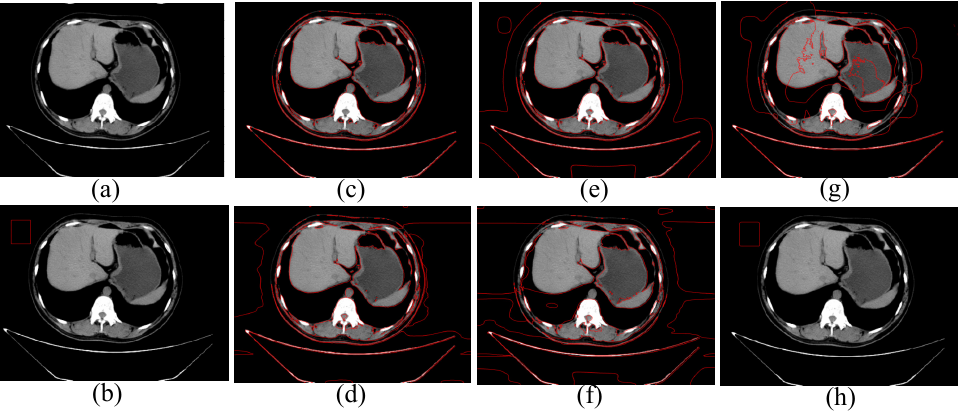
Figure 8. Performance of our method, the LIC model, the LBF model, 0.5-order, 1.5-order on skeleton CT image, and the CV model. ( a ) Original image; ( b ) original image with initial contour; ( c ) the results of our model; ( d ) the results of 0.5 order; ( e ) the results of LIC model; ( f ) the results of 1.5-order; ( g ) the results of LBF model; and ( h ) the results of CV